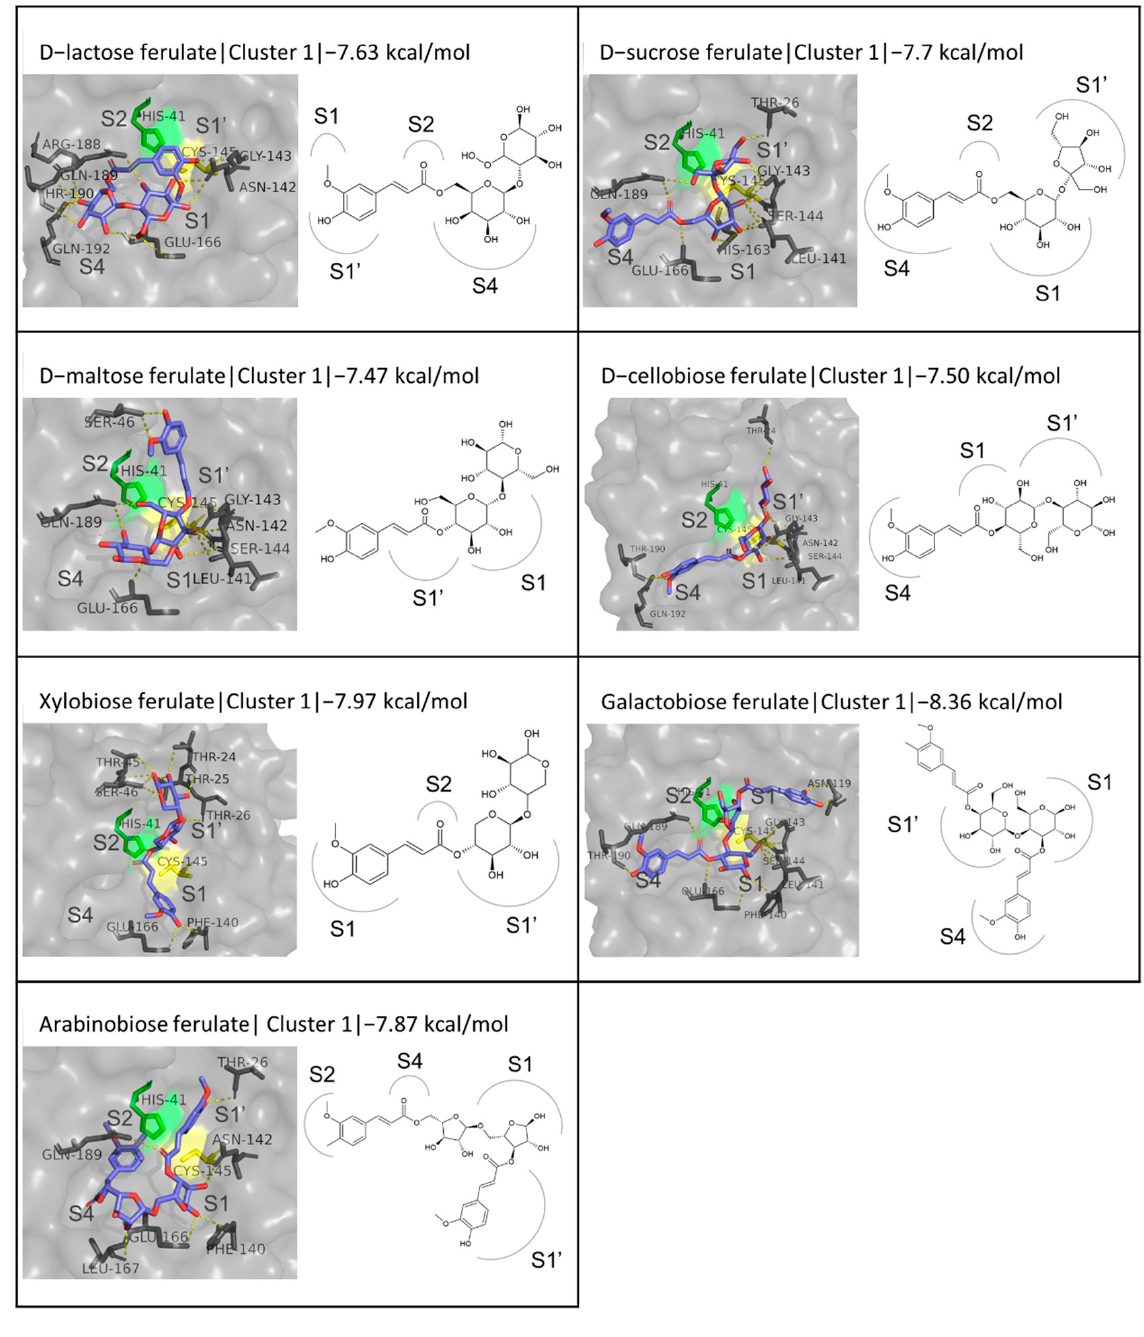
Figure 7. Structures and binding modes of disaccharide esters of FA at the active site of M pro . The occupation of the same regions of the active site is, however, not translated into identical hydrogen bond interactions. The most commonly occurring ones involve residues Gly143 and Thr190 in four out of five ligands and Thr26 in three out of five. Another conformation observed in four out of the five compounds (e.g., the first cluster for D -maltose ferulate) is a vertical one, with the cyclic ring of the sugar closer to FA blocking the catalytic cysteine between the S1 and S1 ′ subsites and the FA extending towards S1 ′ . An evident motif is observed in the interactions between the compounds in this orientation and the protease active site, with Ser46, Gly143, Ser 144, Cys145, and Glu166 emerging as hydrogen bond hotspots. Lastly, a conformation involving the occupation of all four subsites, S4 by the phenolic ring of FA, S2 by its carbonyl group, S1 ′ by the monosaccharide ring closer to FA, and S1 by the second monosaccharide, respectively, is observed in two of the five cases (in the second cluster of D-lactose ferulate and the third clusters of D-sucrose ferulate (Figure S4). This binding pattern is stabilized